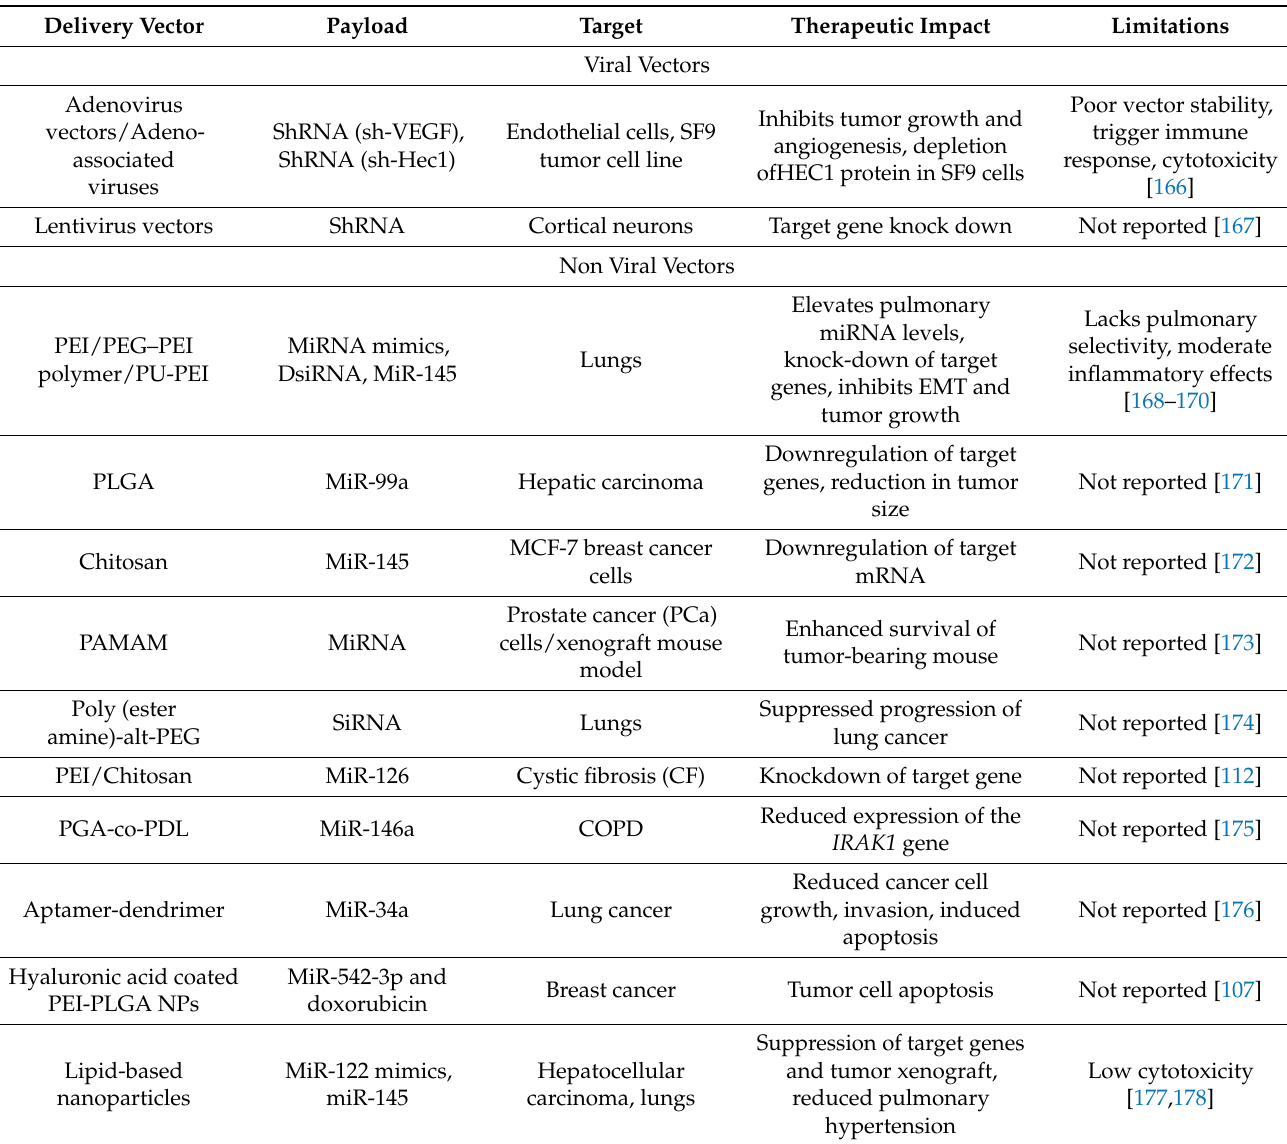
Table 2. Different vectors for the delivery of ncRNAs, their therapeutic effects and potential limitations. Delivery